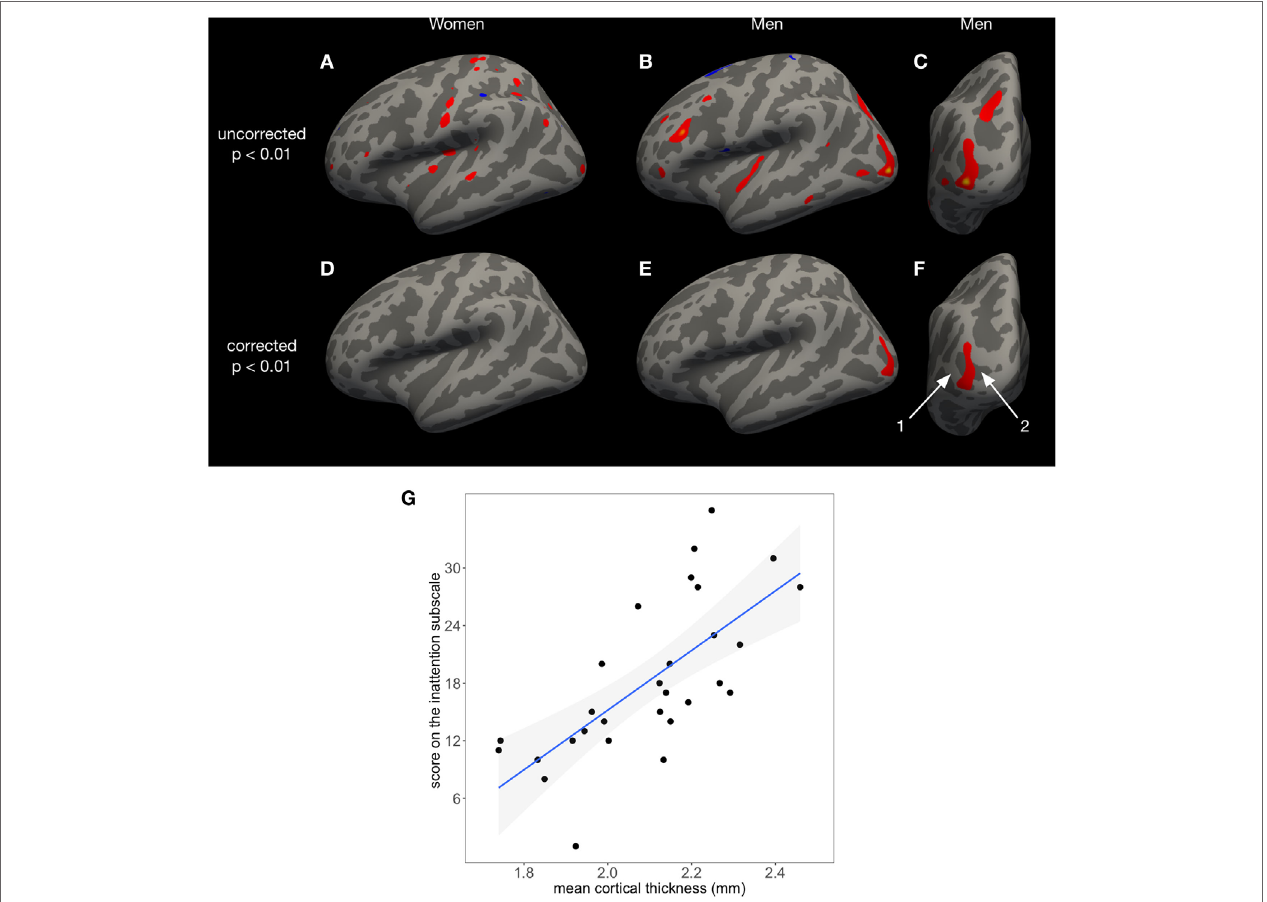
FigUre 1 | The score on the Conners Adult ADHD Rating Scales inattention subscale predicts cortical thickness in a left occipital area in men, covering parts of the middle occipital gyrus (1) and sulcus (2), but not in women. The uncorrected results of FreeSurfer’s surface-based analysis ( p < 0.01) are shown in panel (a) for women and panels (B,c) for men. After cluster-wise correction for multiple comparisons, only the left occipital area in men remains significant [ p < 0.01 (e,F) ]. No significant associations between cortical thickness and inattention were found in women (D) . In panel (g) , individual mean cortical thickness in the left occipital area seen in panels (e,F) is shown as a function of the inattention score. Regression line and 95% confidence intervals (gray shade) are displayed [ F (1,27) = 26.27, p < 0.001, adjusted R 2 =